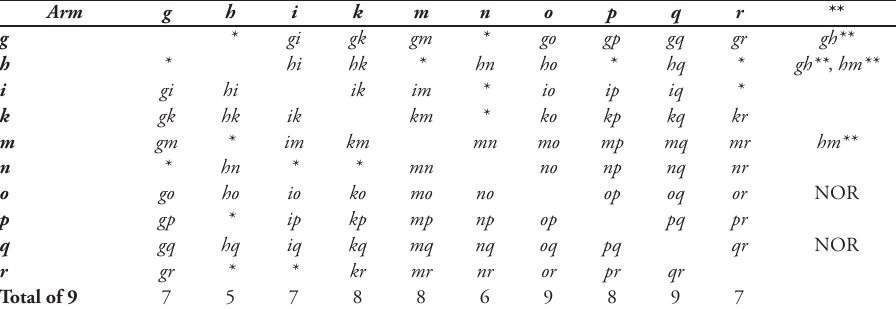
table 1. Serial presentation of chromosomal race specific metacentrics (monobrachial homologs) defined in Sorex araneus. Asterisks mark the fusions absent* in the list of chromosomal races, and potential** for the race/species karyotypes. A double letter designation is given in the alphabetical order following the standard nomenclature of chromosomes of S. araneus (Searle et al. 1991). o , q – NOR-bearing